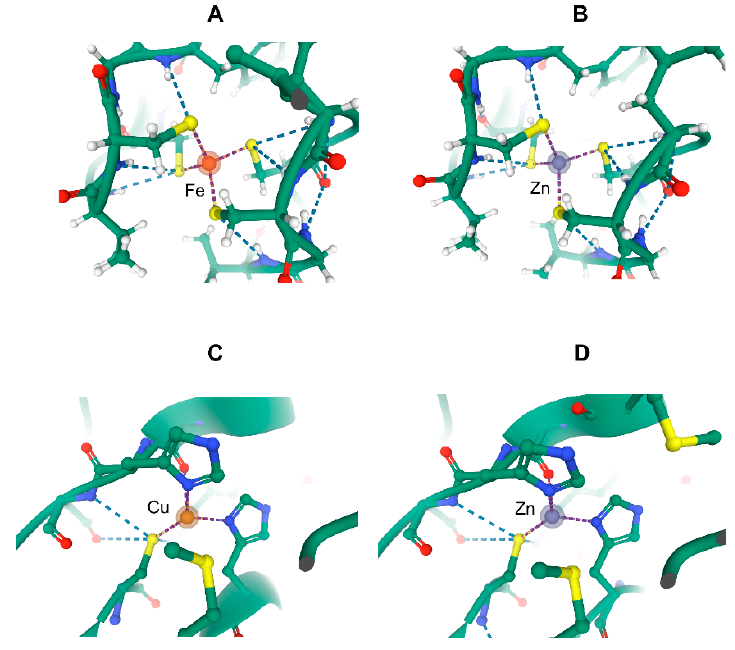
Figure 2. Comparison of the metal-substituted recombinant Clostridium pasteurianum rubredoxin and Pseudomonas aeruginosa azurin produced in Escherichia coli . The panels show the metal ion coordination spheres for ( A ) Fe(III) rubredoxin (RCSB PDB 1IRO, resolution 1.10 Å), ( B ) Zn(II) rubredoxin (1IRN, resolution 1.20 Å), ( C ) Cu(II) azurin (5AZU, resolution 1.90 Å), and ( D ) Zn(II) azurin (1E67, resolution 2.14 Å). The images were generated on the rcsb.org site using Mol* (D. Sehnal,